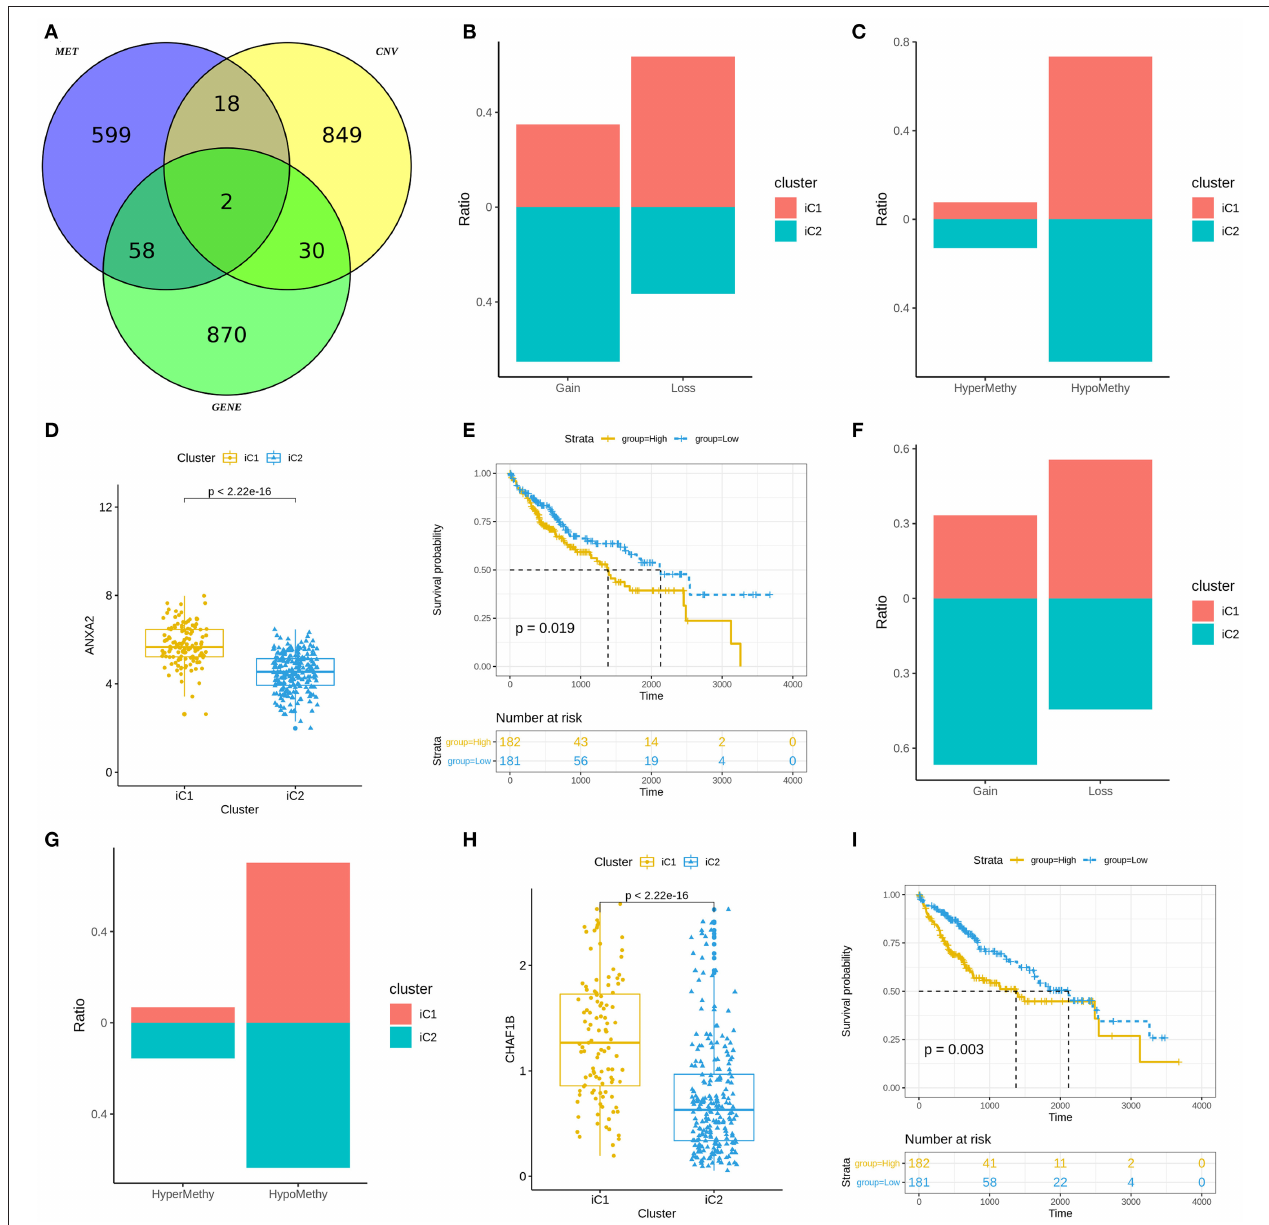
FIGURE 6 | Molecular features of gene subtypes in liver cancer. (A) Venn diagram showing differences in CNVs, methylation and mRNA expression between iC1 and iC2 subtypes. (B) Proportions of ANXA2 gain and loss in iC1 and iC2 subtypes. (C) Proportions of ANXA2 hypermethylation and hypomethylation. (D) Box plots showing the differences in ANXA2 expression between iC1 and iC2 subtypes. (E) Kaplan-Meier survival curves for ANXA2 expression. (F) Proportions of CHAF1B gain and loss in iC1 and iC2 subtypes. (G) The proportion of CHAF1B hypermethylation and hypomethylation. (H) Box plots showing the differences in CHAF1B expression between iC1 and iC2 subtypes. (I) Kaplan-Meier survival analysis results for CHAF1B expression.